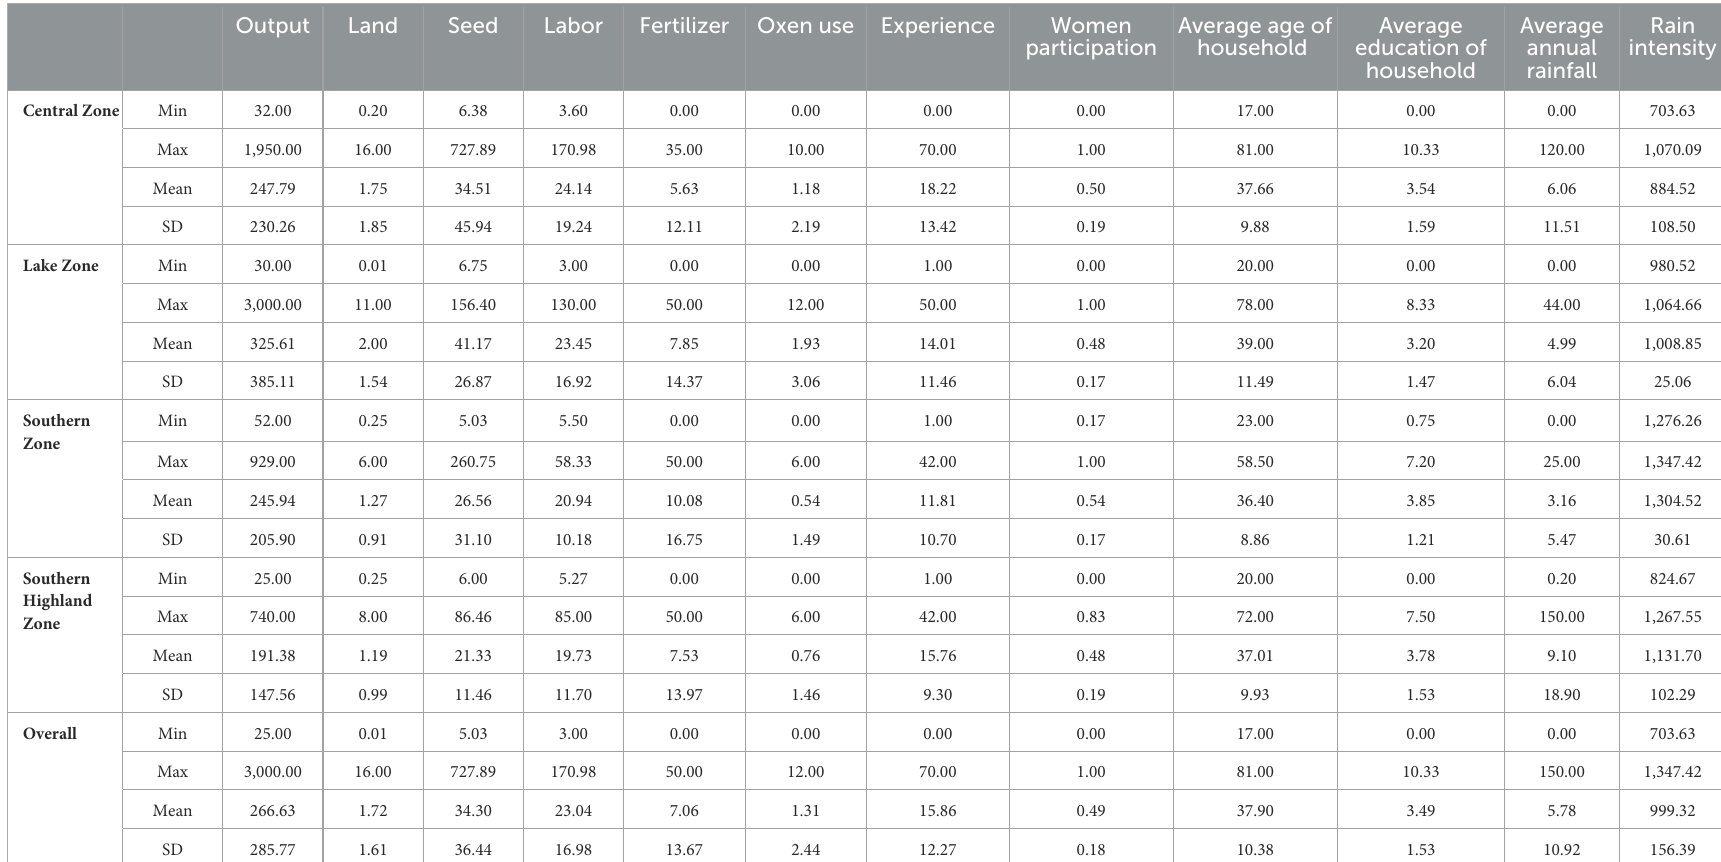
TABLE 1 Descriptive statistics for groundnut farmer in four regions and the whole sample.